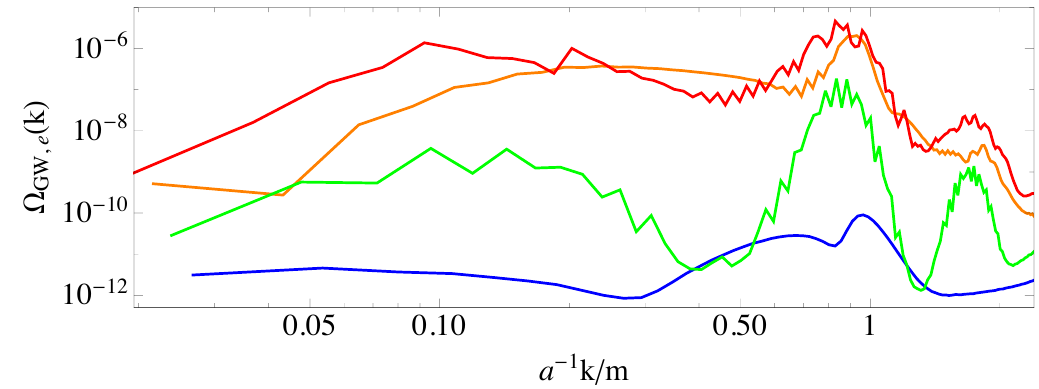
Figure 9 . Spectrum of gravitational waves (cid:10) physical GW ; e ( k ) for KKLT model as a function of the momentum a (cid:0) 1 k=m at a = 5 : 72 (blue), a = 6 : 41 (green), a = 7 : 07 (orange) and at the end of the simulation a = 8 : 3 (red). One can clearly see two peaks at k=a . 1 and k=a . 2. The simulation which led to the results was performed with W 0 = 10 (cid:0) 5 and 512 3